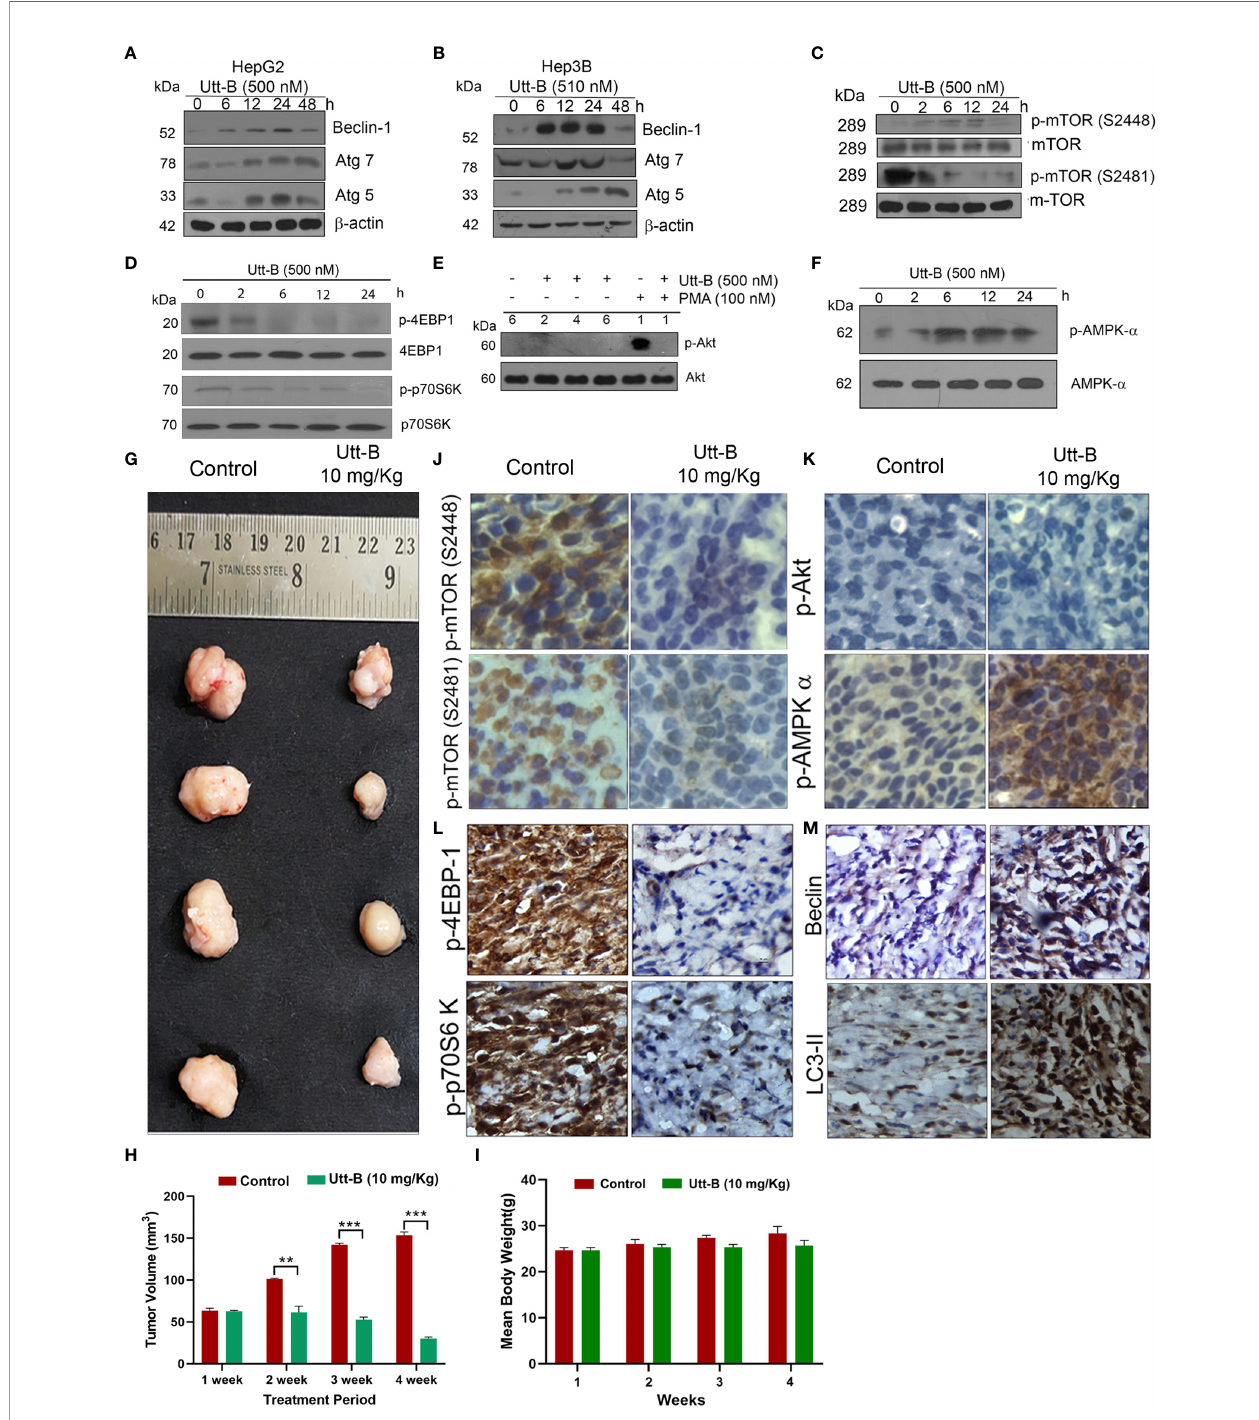
FIGURE 2 | Utt-B activates autophagy-related proteins and modulates autophagy by regulating the AMPK-mTOR signaling axis. (A) Immunoblot analysis shows that Autophagy markers Beclin1, Atg7 and Atg5 are elevated up to 24h upon Utt-B treatment (500nM) and declines at 48h in HepG2 cells. (B) Beclin1, Atg7, Atg5 elevates up to 24h upon Utt-B treatment(500nM) and decline at 48h in Hep3B cells. (C) Utt-B treatment inhibits both p-mTOR (S2448) and p-mTOR (S2481). (D) Utt-B treatment signi fi cantly down-regulates p-70S6 Kinase and p-4EBP1, the downstream targets of mTOR. (E) Utt-B completely abolishes PMA-induced activation of Akt. (F) Utt-B phosphorylates AMPK alpha. (G, H) Utt-B signi fi cantly inhibits the growth of HepG2 xenografts in NOD-SCID mice. (I) Change in Body weight of mice in control and Utt-B treatment is non-signi fi cant throughout the period of experiment (J – M) Immunohistochemical analysis shows that Utt-B administration down-regulates the activation of p-mTOR (S2448), p-mTOR (S2481), p-70S6 Kinase, and p-4EBP1, with no change in p-Akt status and up-regulates the expression of p-AMPK-alpha and the autophagy markers, Beclin 1 and LC3. ** level of signi fi cance 2, *** level of signi fi cance